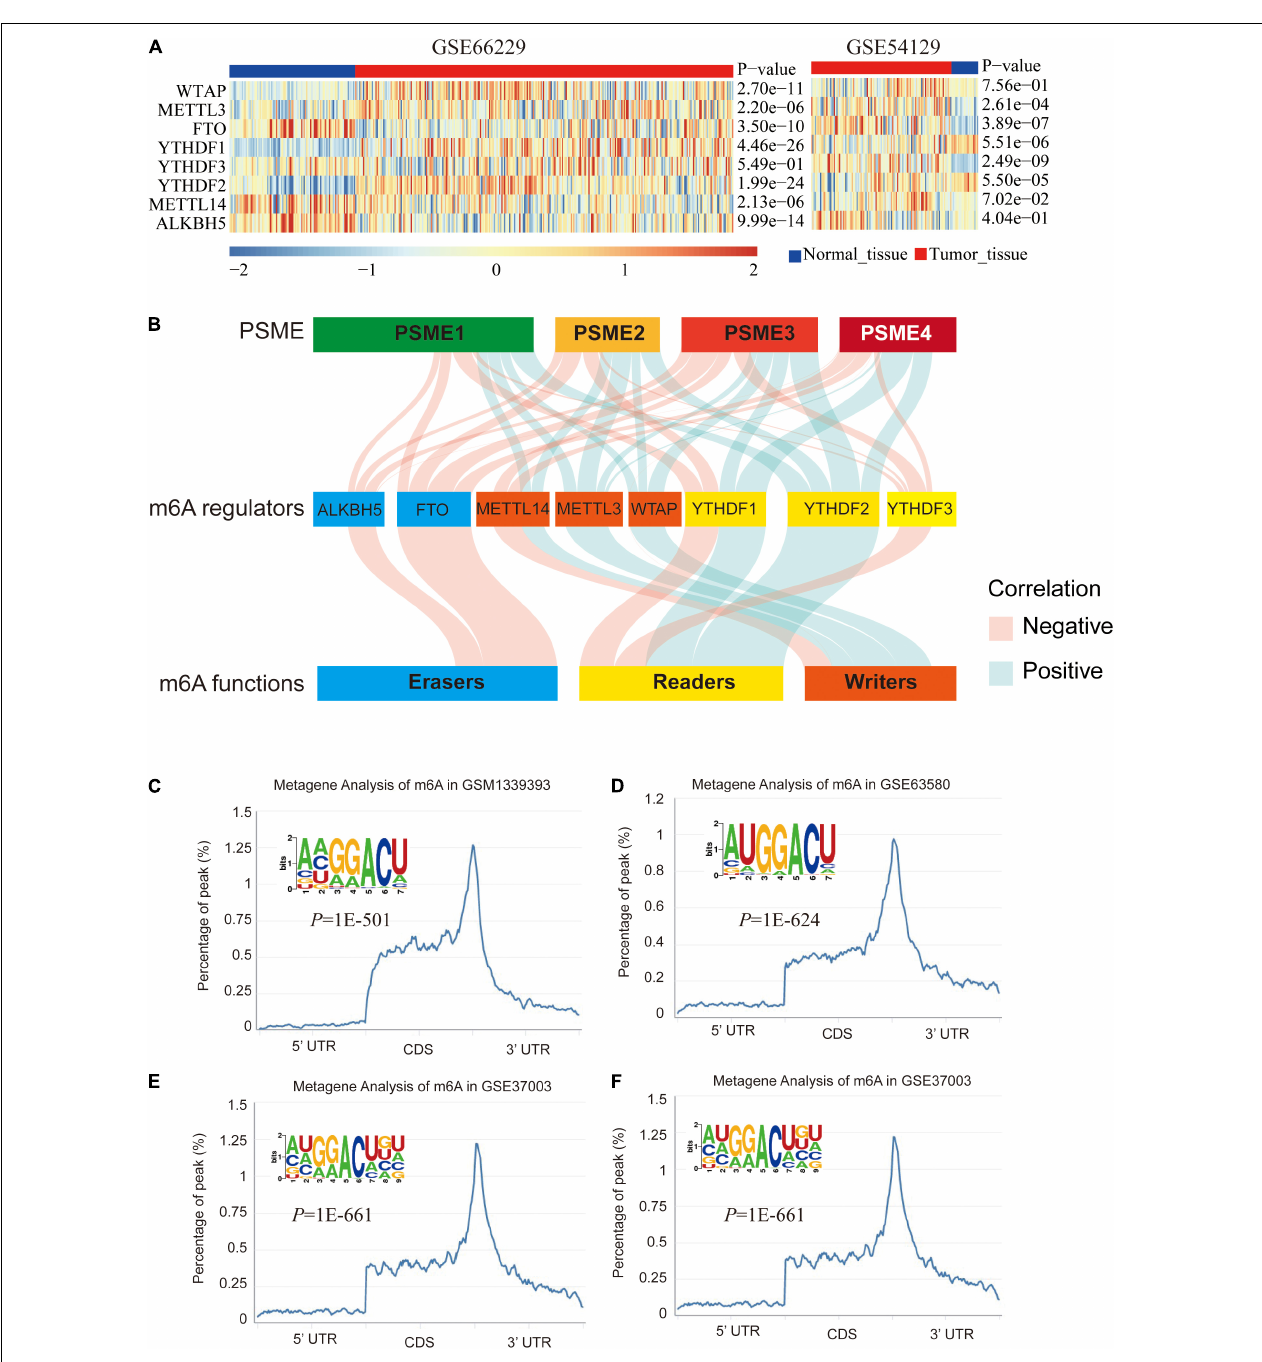
FIGURE 7 | m6A modification of PSME genes. (A) The expression levels of m6A-related genes in GSE66229 and GSE54129 datasets. (B) Alluvial diagram showed the correlation between m6A-related gene expression and PSME genes. (C–F) The normalized distribution of m6A peaks and identified m6A motif in PSME1–4, respectively, based on RMBase V2.0